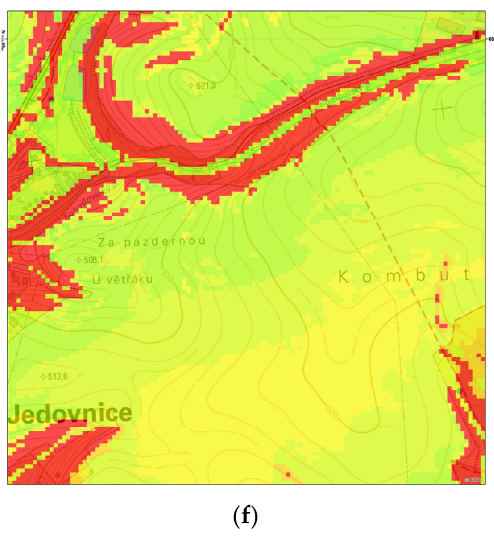
Figure 11. Entry cost maps of landscape potential for DS deployment for MCA variants from the Jedovnice area: ( a ) Experts, ( b ) Theorists, ( c ) Var. 3, ( d ) Pairs, ( e ) MES, ( f ) Saaty.